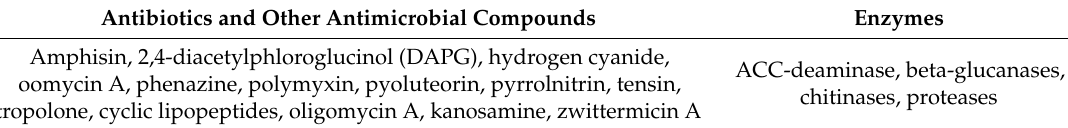
Table 1. Representative bioactive compounds produced by di ff erent plant-growth-promoting bacteria (PGPB) species against